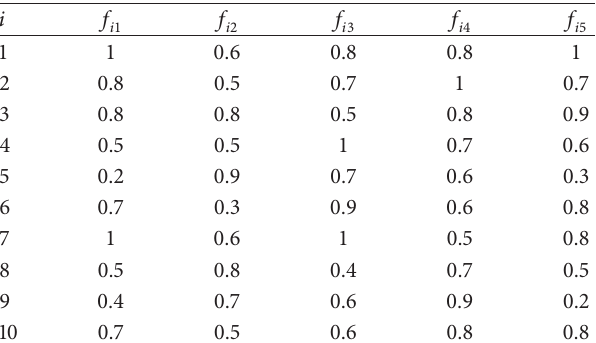
Table 2: Data of Example